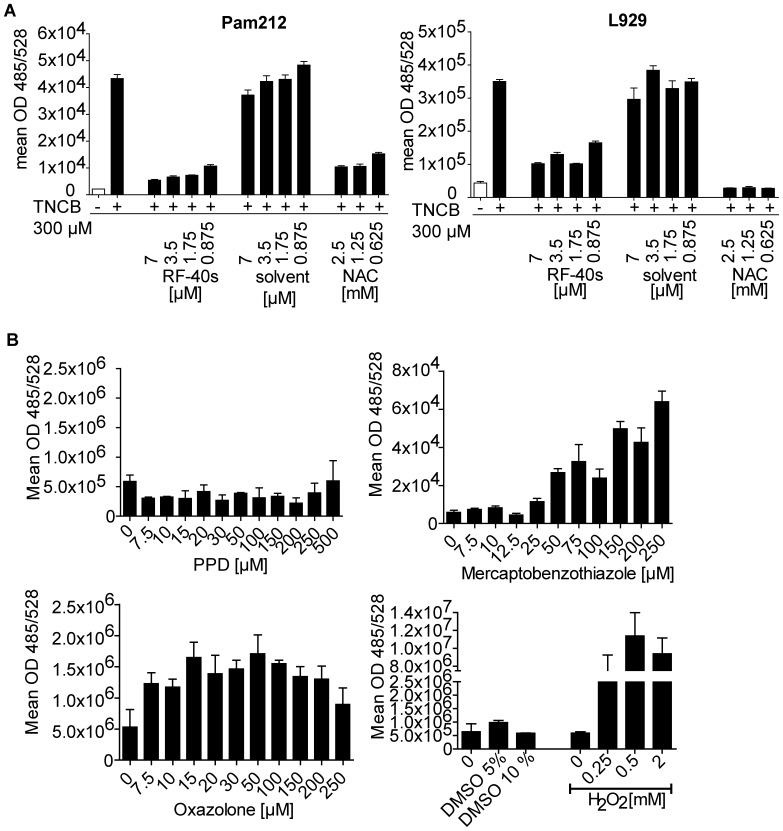
Contact sensitizers induce ROS production in murine Pam212 and L929 cell lines in vitro.
(A) Pam212 or L929 cells were incubated with CM-H2DCFDA (5 µM) for 15 min before addition of RF-40s, solvent or NAC. 15 min later TNCB (300 µM) was added. OD485/528 was measured every 10 min for 1 h. Results show the calculated mean OD +/− SD of triplicate wells of all time points analyzed. One representative of three independent experiments is shown. (B) Mean fluorescence was calculated comprising all time points after incubation of Pam212 cells with CM-H2DCFDA and treatment with different concentrations of the pro-hapten paraphenylenediamine (PPD), the extreme sensitizer oxazolone or the moderate sensitizer mercaptobenzothiazole (MBT) as in (A). DMSO and H2O2 served as solvent and positive control, respectively.